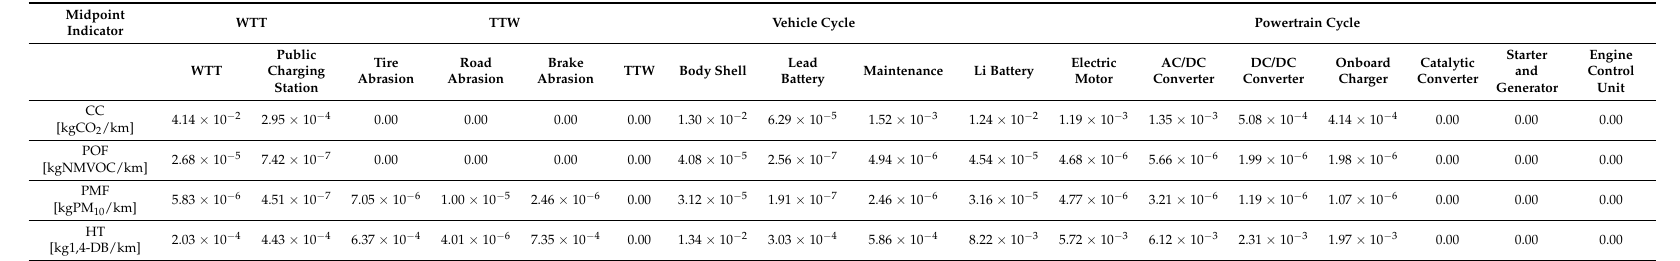
Table A1. LCI of a 30 kWh EV for the European electricity mix (276 g CO 2 /kWh) (based on